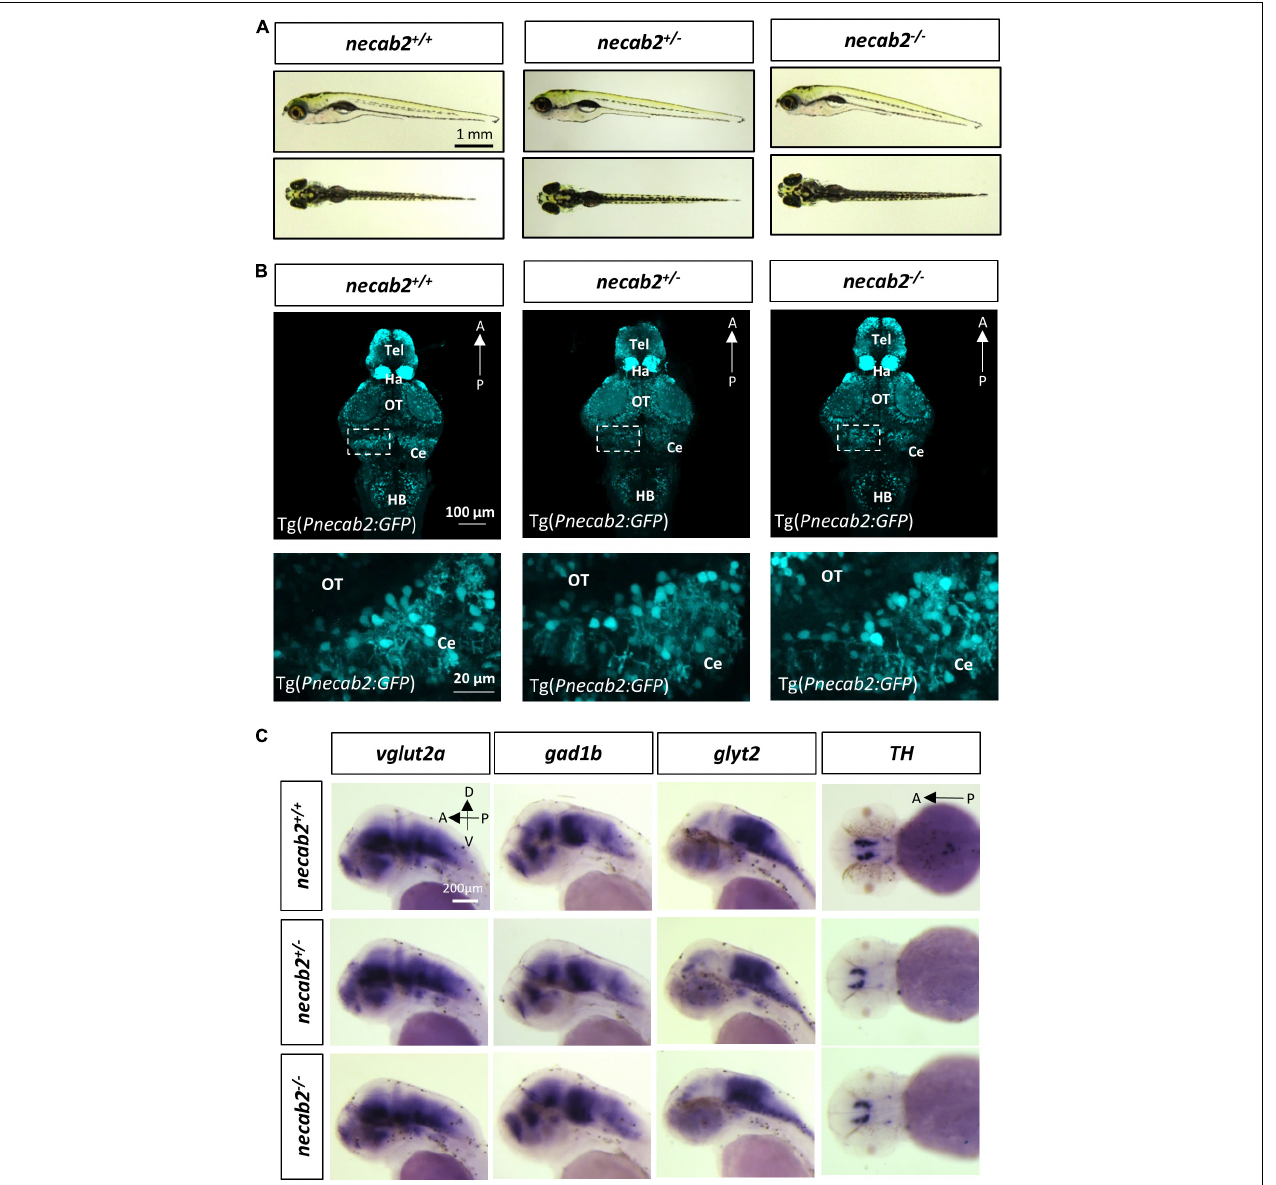
FIGURE 4 | The necab2 − / − larvae display grossly normal morphology and neuronal marker expression. (A) The necab2 + / − and necab2 − / − larvae exhibited grossly normal appearance compared to wildtype siblings. The 7 dpf larvae derived from the heterozygous necab2 + / − mating were imaged blindly and followed by genotyping. Scale bar = 1 mm. (B) The necab2 + / − and necab2 − / − larvae exhibited normal neural cytoarchitecture compared to wildtype siblings. A total of 7 dpf larvae were derived from heterozygous necab2 + / − mating in the Tg( Pnecab2:EGFP ) background. Genotyping using the dissected tail was done after fixation for anti-EGFP immunofluorescence staining. Scale bar = 100 µ m. The region in the dashed white box was shown at higher magnification below. Scale bar = 20 µ m. (C) The necab2 + / − and necab2 − / − larvae exhibit grossly normal composition of neuronal types. Spatial analysis of the glutamatergic ( vglut2a ), GABAergic ( gad1b ), glycinergic ( glyt2 ), and dopaminergic ( TH ) neurons by whole-mount mRNA in situ hybridization was conducted blindly in the embryos derived from in-cross of necab2 + / − followed by genotyping. For each group, a total of 20 larvae were processed for in situ hybridization in order to obtain at least three homozygous larvae respectively. Scale bar = 200 µ m. dpf, day post-fertilization; Tel, telencephalon; Di, diencephalon; Ce, cerebellum; re, retina; Ha, habenula; OT, optic tectum; MHB, midbrain-hindbrain boundary; HB, hindbrain; lens, crystalline lens.